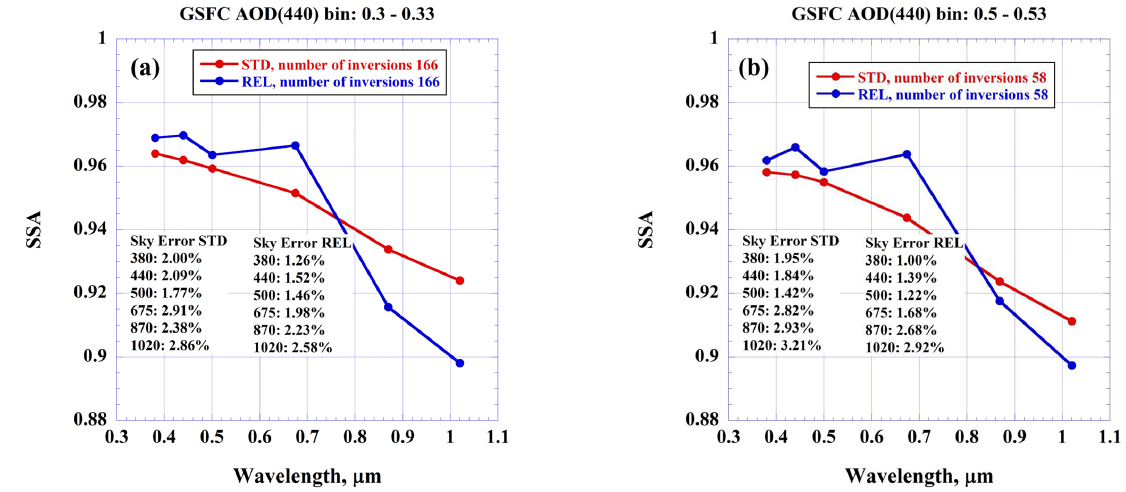
Figure 8. SSA averaged over AOD(440) bins for the GSFC AERONET site: (a) 0.3–0.33 and (b)